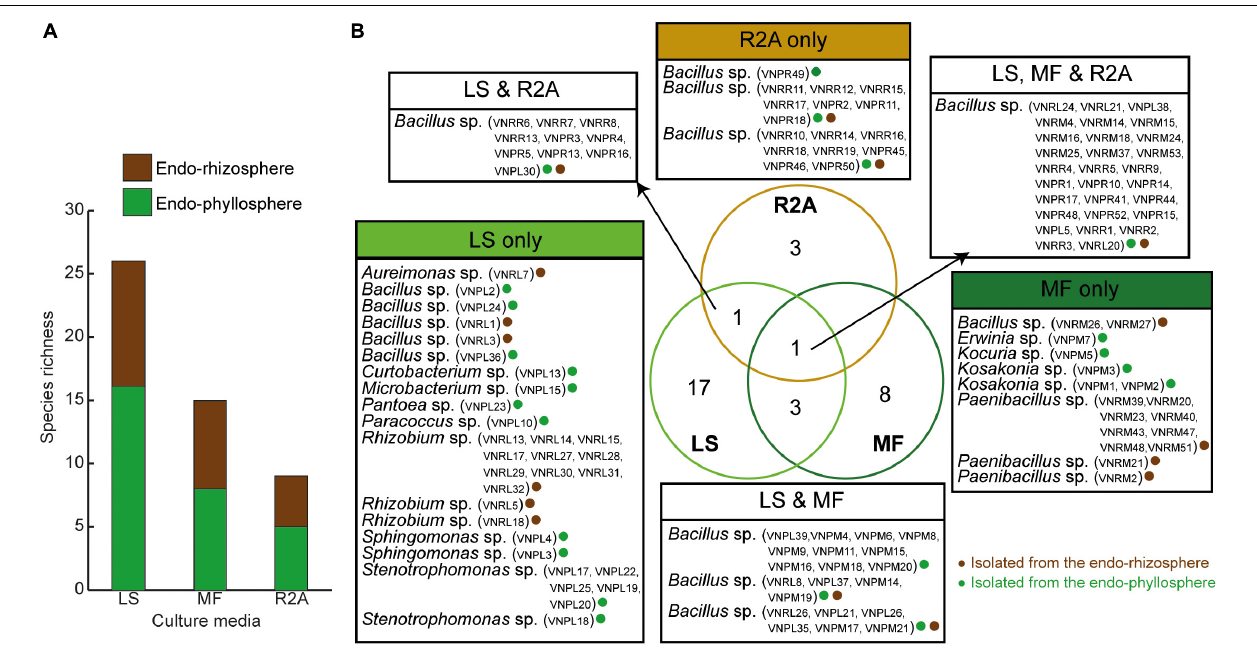
FIGURE 3 | (A) Richness of endophytic populations present in the endorhizosphere and endophyllosphere of sunflower plants, grown on the tested culture media; (B) Venn diagram representing potential species among the tested culture media as affected by the extracted plant spheres. LS, leaf surface-inoculated; MF, leaf-membrane filter; R2A, Reasoner’s 2A culture medium. The strain ID of isolates belonging to the related potential species appear in